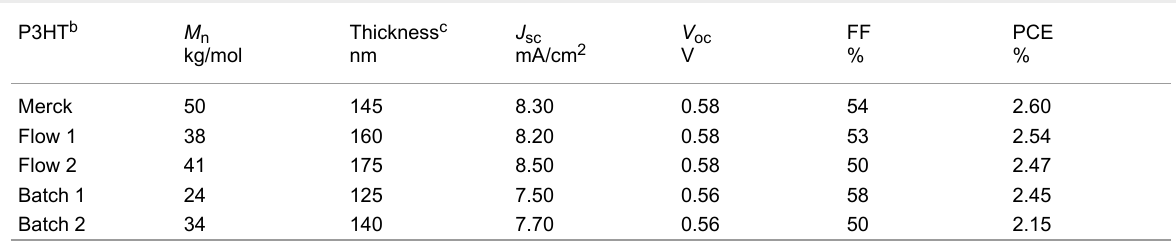
Table 4: Solar cell data for devices containing various P3HT samples. a P3HT b M n kg/mol